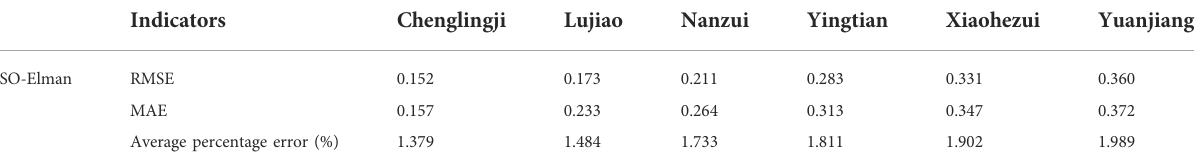
TABLE 2 Performance analyses of PSO-ENN on real-time water level